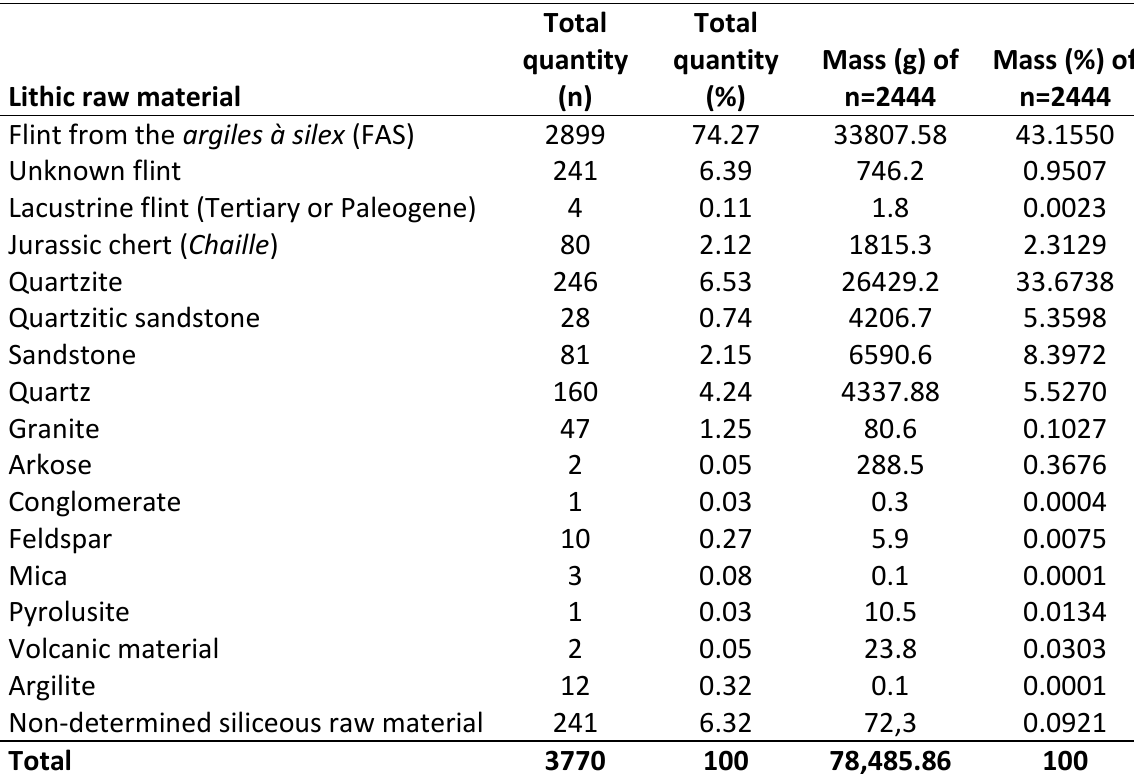
Table 2. Silicious raw materials from GH